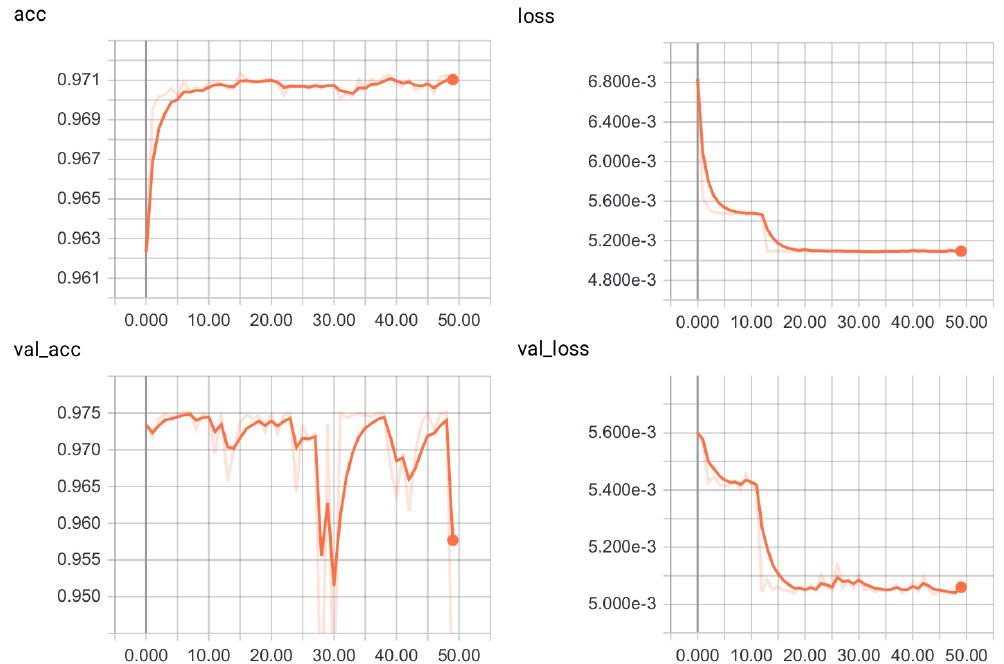
Figure 6. Centralized training of the autoencoder for 50 epochs on benign data only using 20% of the data for validation to avoid overfitting (X-axis depicts epochs, and Y-axis depicts accuracy and loss value on training and validation